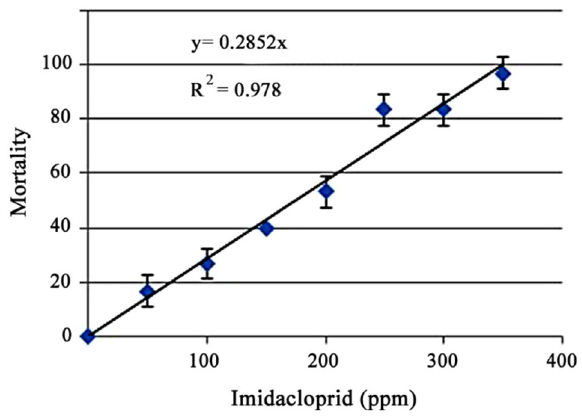
Figure 1. The concentration response of O. niloticus exposed to different concentrations (0–350 ppm) of Imid (n = 10 fish). Values were expressed as mean ± standard deviation (SD), bars refer to